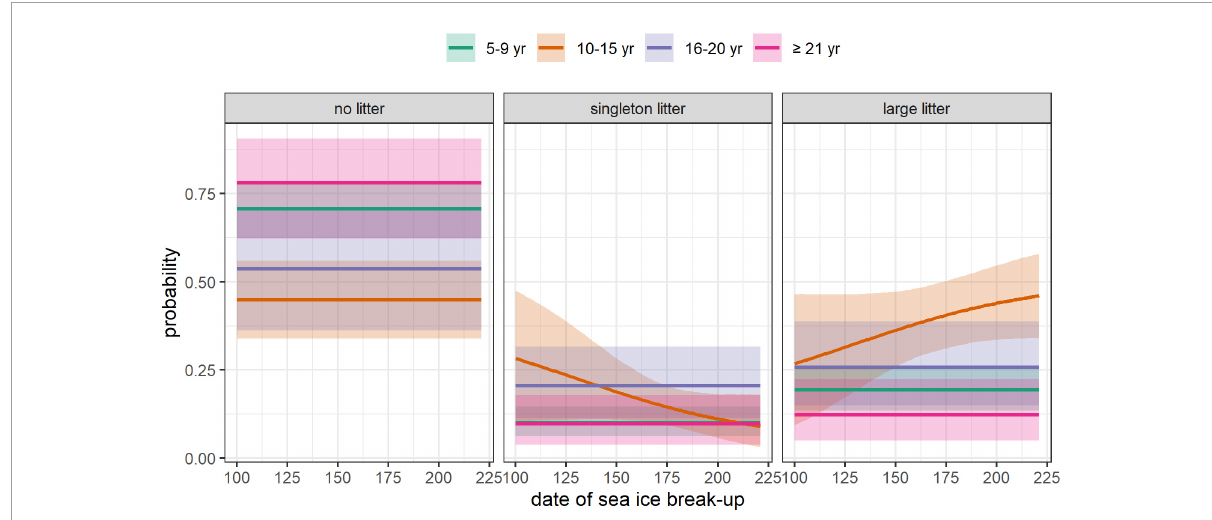
FIGURE6 Effect of the date of sea-ice break-up in the year prior to capture on the absolute probability of having no litter, a singleton litter, or a large litter, depending on female’s age. The mean (solid line) and 95% CRI (shading) are provided. All the covariates other than DateBreakUp were set at their mean value ( DateCapture = 104, i.e., April 14, Size = 195 cm, WinterAO = –0.06, PriorWinterAO = 0.01, PriorSpringAO =